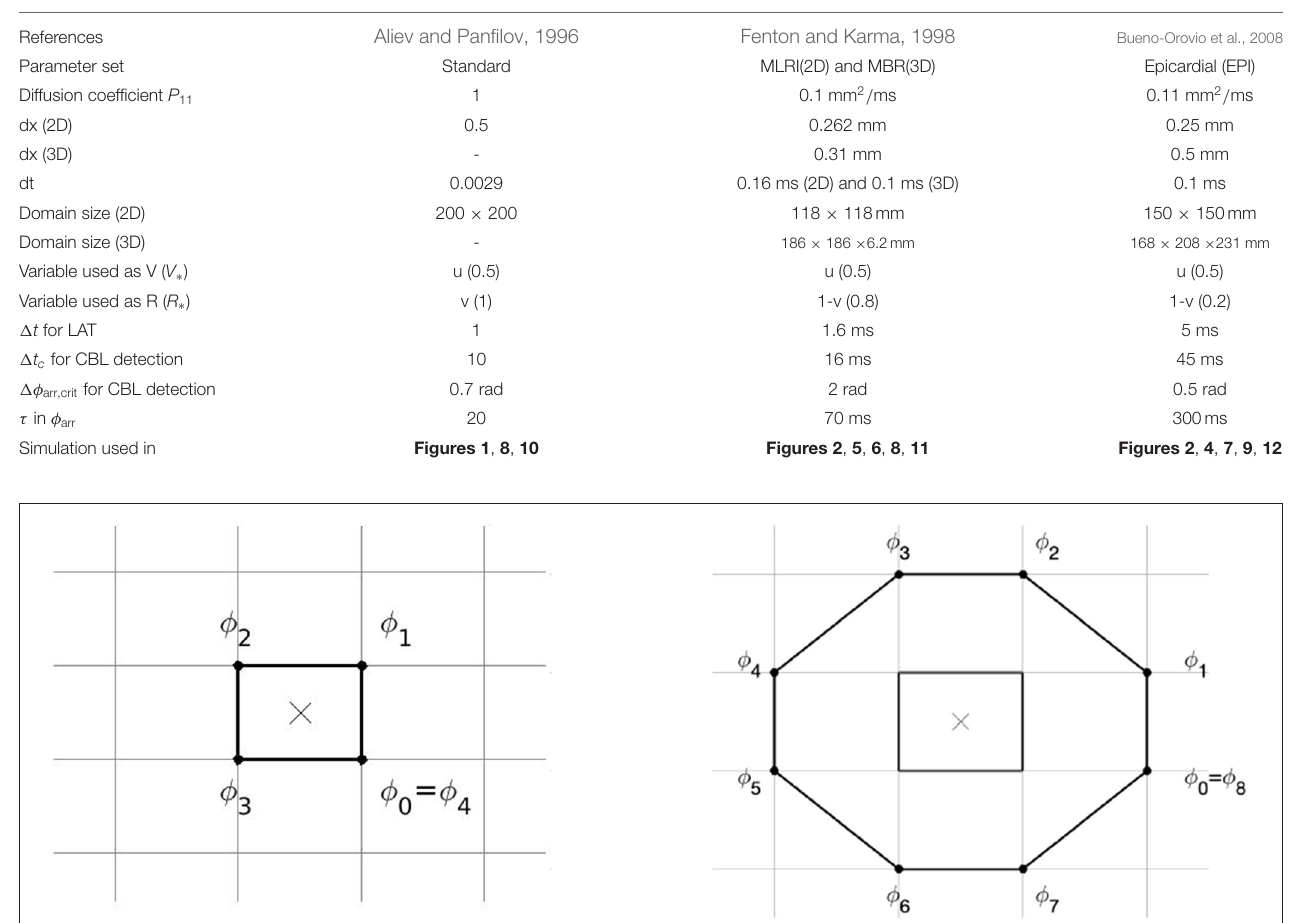
TABLE 1 | Overview of mathematical models of cardiac excitation and parameters used in simulations throughout this work. Kinetics